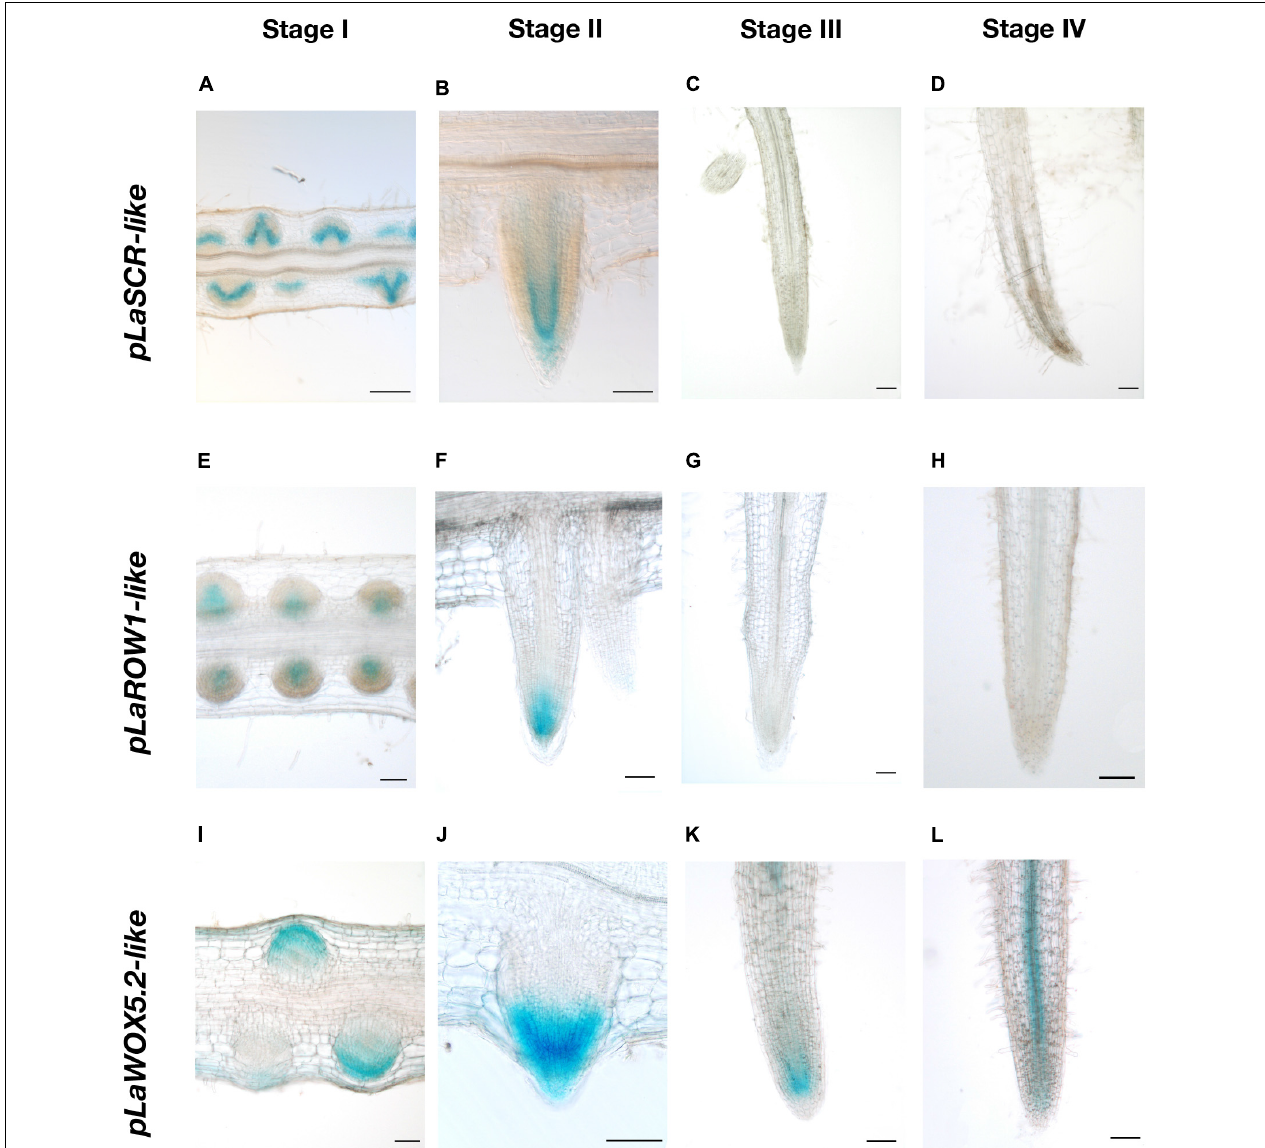
FIGURE 5 | Tissular expression patterns of three meristematic markers during rootlet development. The promoter activities of three genes typically expressed in the meristematic zone were studied with a GUS-reporter-based analysis on 80- µ m longitudinal sections of transgenic hairy-root tips. Images from stages I to IV are shown for each promoter (A–D) pLaSCR-like:GUS, (E–H) pLaROW1-like:GUS , (I–L) pLaWOX5.2-like:GUS. Scale bars: (A–L) 100 µ